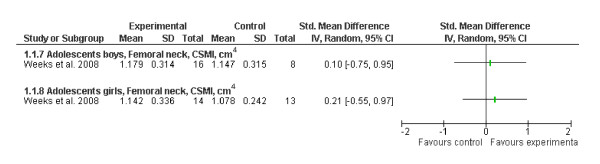
Effects of exercise on bone strength (standard mean difference, 95% CI) in adolescent boys and girls at the femoral neck. The squares represent the test values for the individual study.